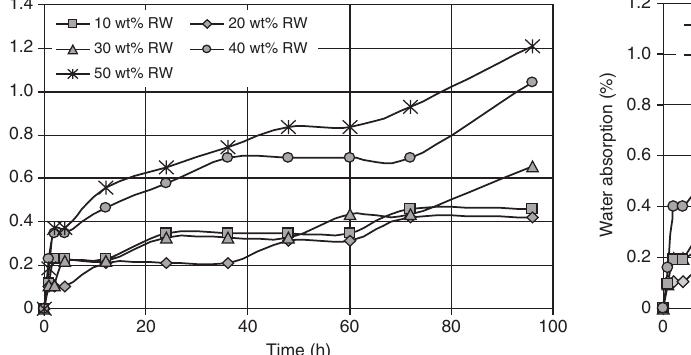
Figure 4 WA as a function of soaking time for different weight percentages of almond shell particles in RW.